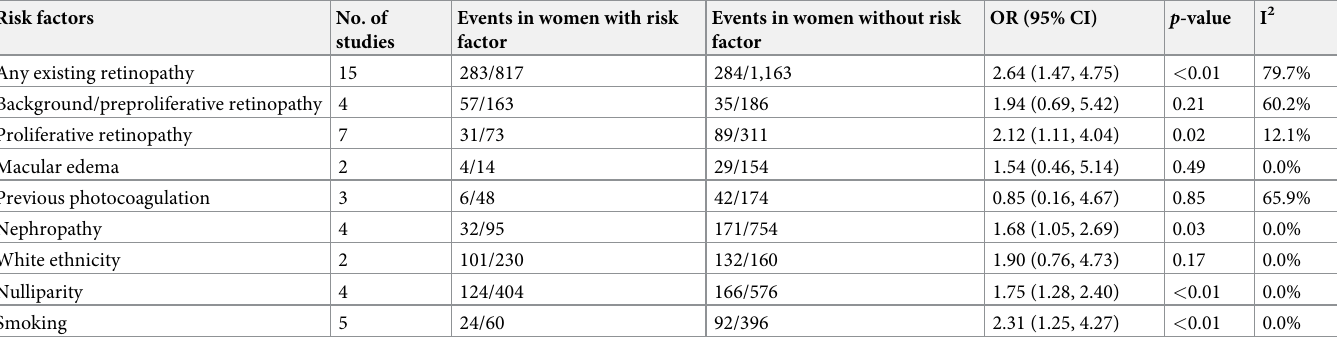
Table 2. Risk factors for worsening or new onset retinopathy in pregnant women with preexisting